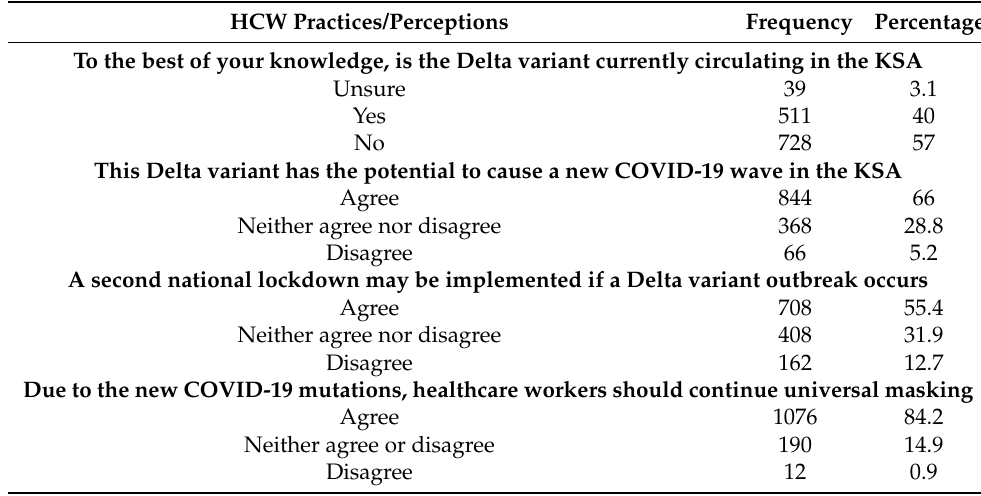
Table 4. HCWs’ expectations about the practices needed to combat the COVID-19 Delta variant. HCW